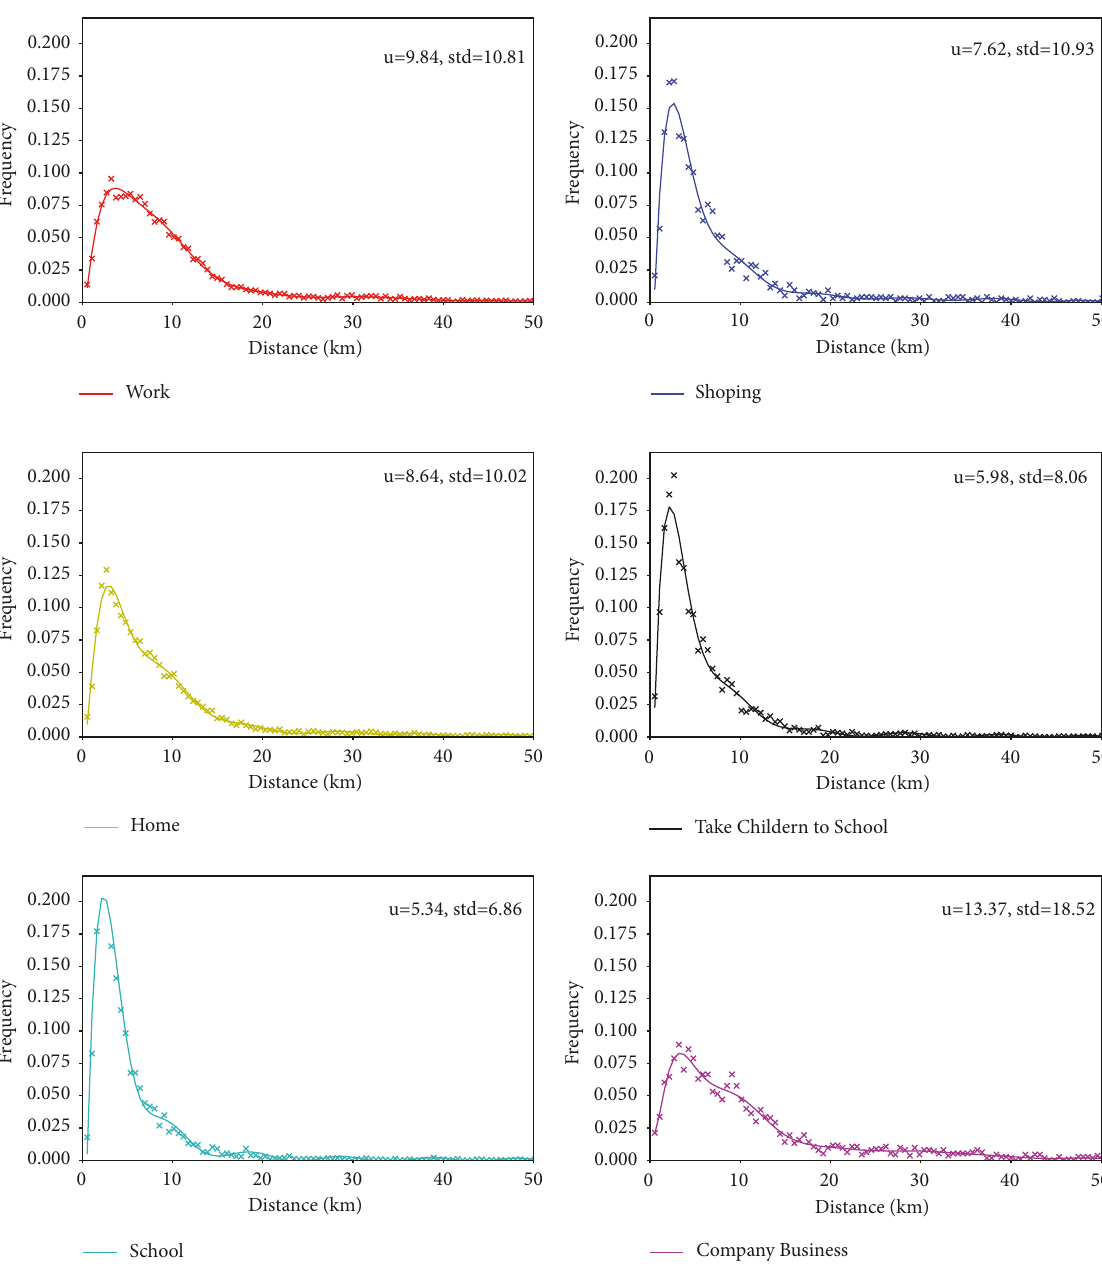
Figure 6: Trip distance distribution with 6 travel